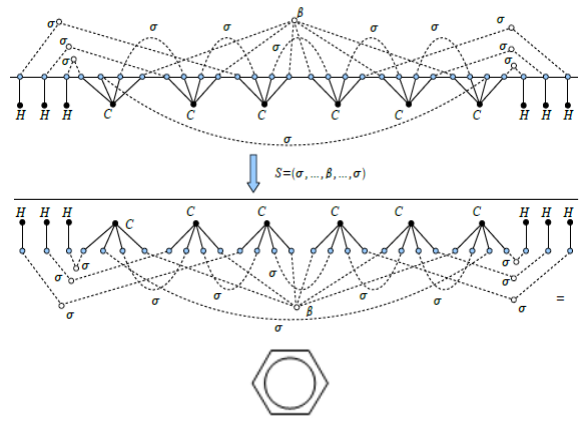
Fig. 4. Modeling a benzene molecule by splices